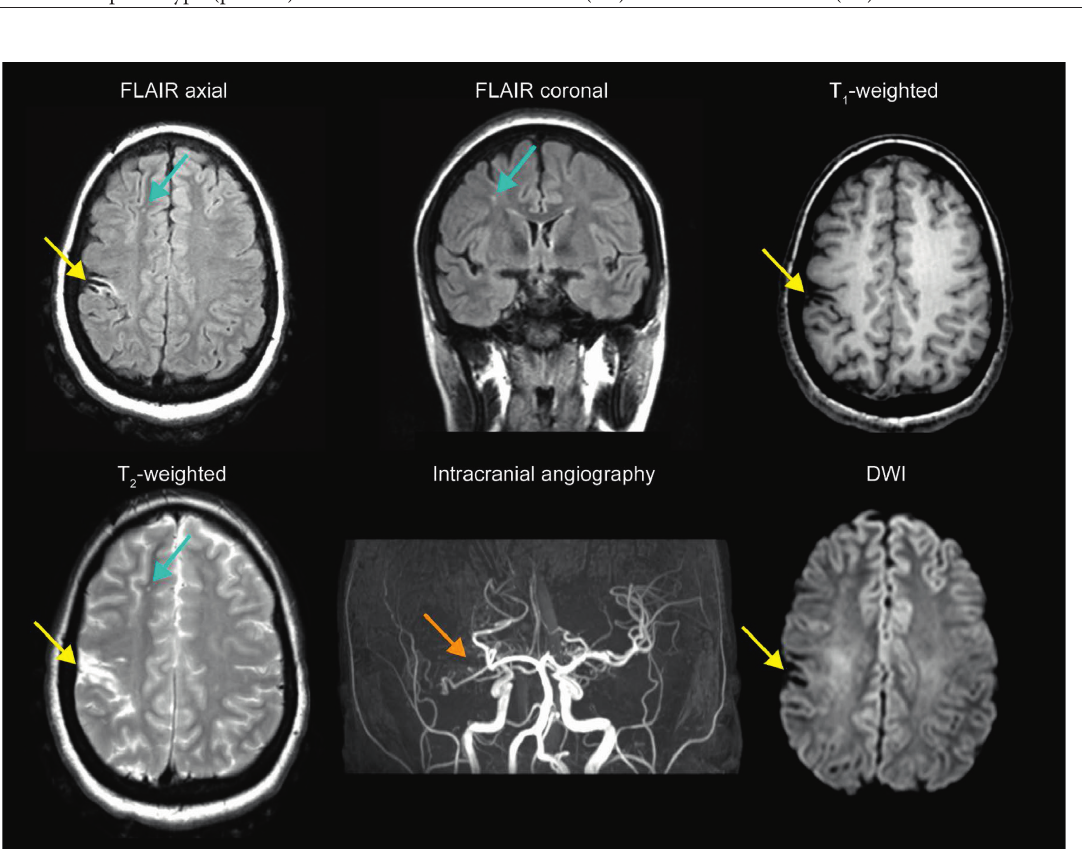
Figure 1: Representative scans from the multimodal magnetic resonance imaging protocol from a Black 9-year-old female with hemoglobin SS phenotype. Chronic stroke is apparent (yellow arrows), with additional right parietal and frontal lobe chronic silent cerebral infarcts (blue arrows), which largely colocalize with patchy T 2 -hyperintense foci. On intracranial angiography, there is near-complete occlusion of the terminus of the right internal carotid artery with a very short proximal portion of the right M1 segment visible (orange arrow). Extensive collateral vessels are identified extending into the basal ganglia region on the right side. No evidence of acute infarct is visible on diffusion- weighted imaging (DWI).